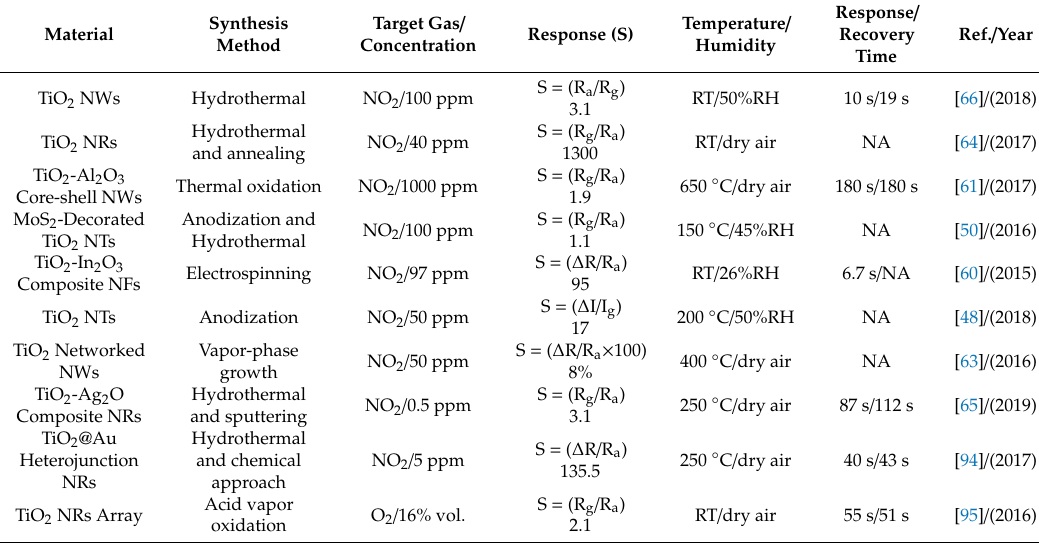
Table 5. Summary of the gas sensing properties of TiO 2 -based nanostructure and heterostructure sensors towards oxidizing